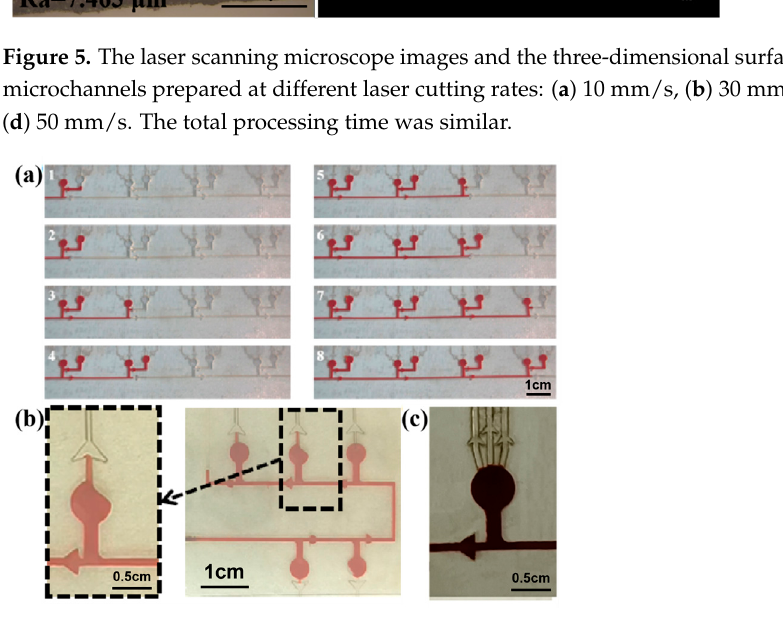
Figure 6. ( a ) CBV#1 takes effect when the secondary microreservoirs are set up. ( b ) When setting a single spiracle valve, part of the air is blocked in the microreservoir and cannot be released. ( c ) Three parallel CBV#2 vaults are designed to ensure that the air can be vented out thoroughly.